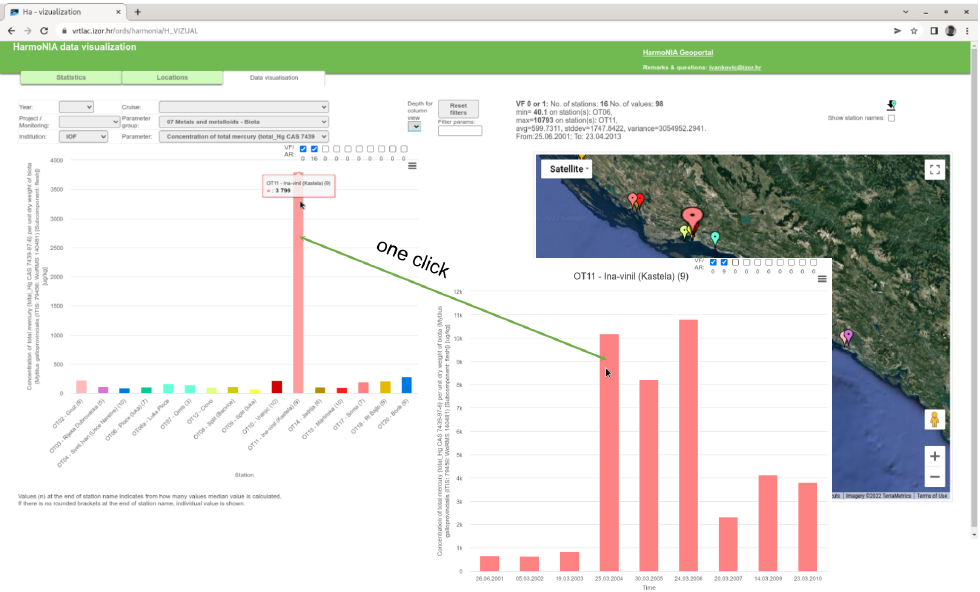
Figure 9. Illustration of one click status to trend